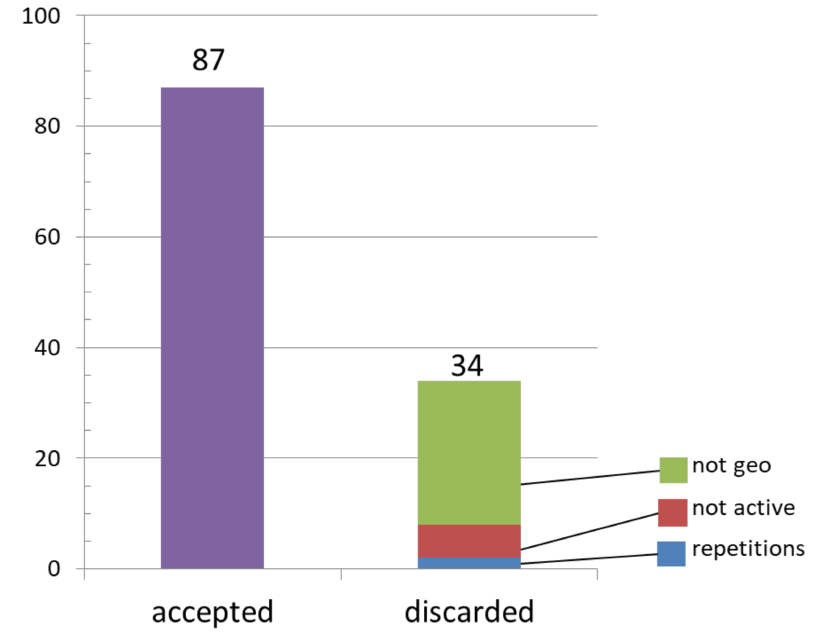
Figure 2. Chart representation of the number of selected and discarded projects within the initial subset. The high percentage of projects accepted (71.9%) and discarded as not-geo, but still representative of current CS projects, (71.9 + 21.5 = 93.4%) indicates the good consistency and update status of the original Wikipedia